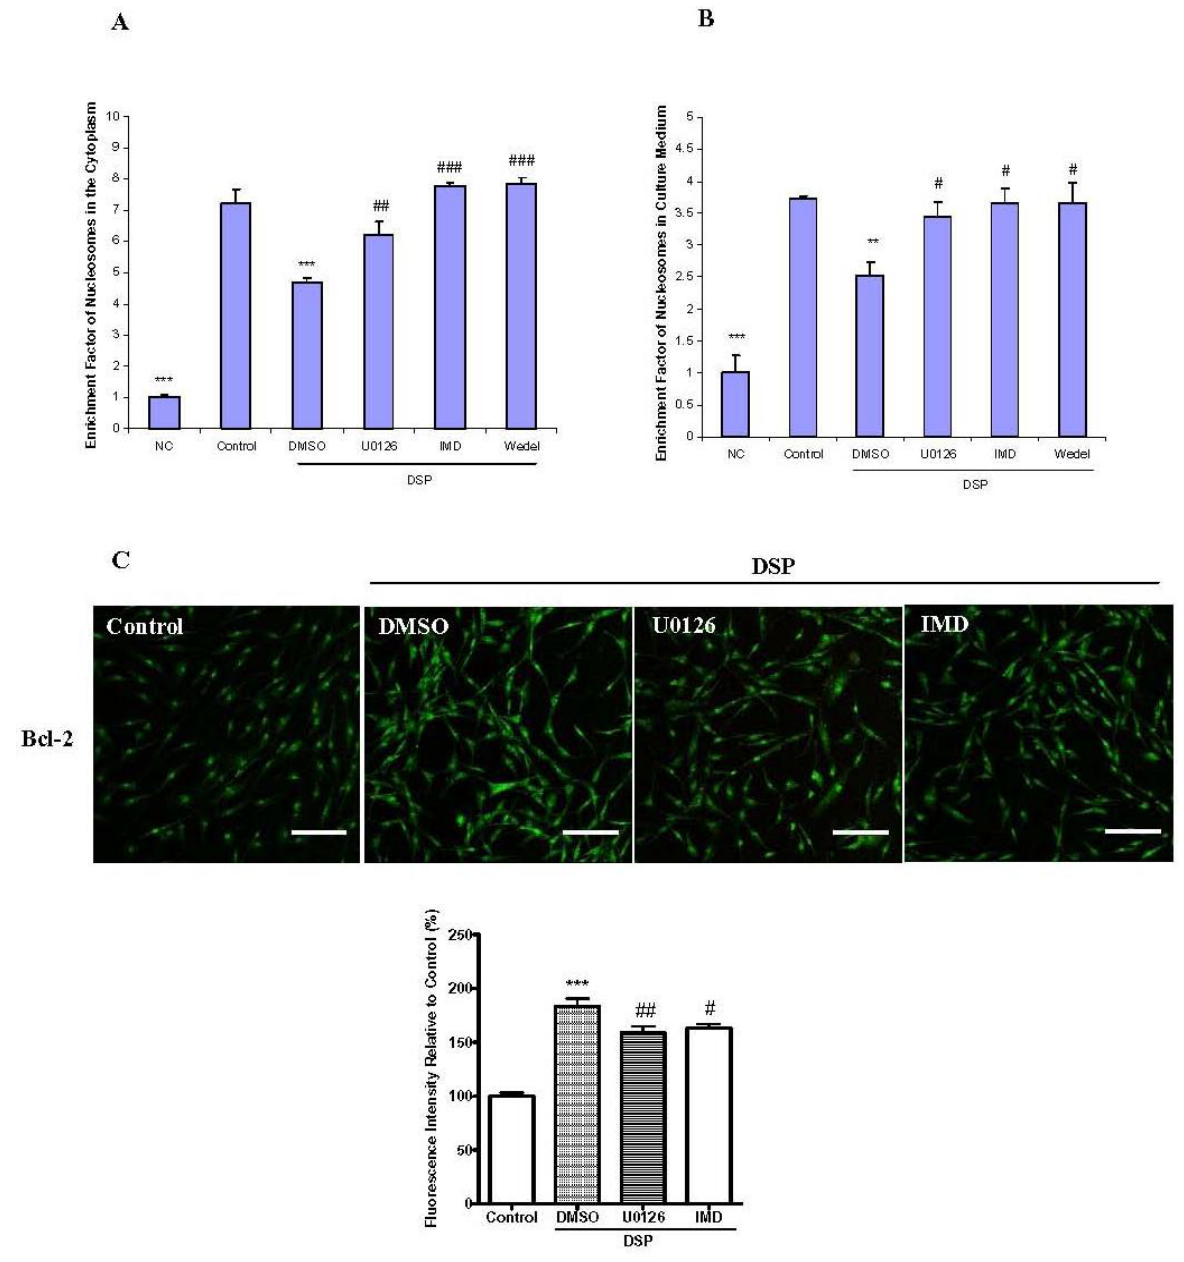
FIGURE 5. DSPs reduce serum starvation–induced apoptosis/necrosis and increase expression of Bcl-2 through activation of ERK and NF-κB in human VSMCs. Serum-starved cells were treated with 0.2 μl/ml of DSPs for 24 (C) or 48 h (A,B). The cells cultured in complete medium were regarded as negative control (NC). 10 μM of U0126, 5 μM of wedelolactone, or 30 nM of IMD-0354 were added to cells 30 min prior to treatment with DSPs. (A) DSP-induced anti–cell apoptosis is inhibited by MEK or NF-κB inhibitors. The rate of apoptosis is reflected by the enrichment factor of nucleosomes in the cytoplasm as determined by Cell Death Detection ELISA. (B) DSP-induced anti–cell necrosis is inhibited by MEK or NF-κB inhibitors. The rate of necrosis is reflected by the enrichment factor of nucleosomes in culture medium as determined by Cell Death Detection ELISA. (C) Bar graphs show the effects of MEK and NF-κB inhibitors on DSP-induced expression of Bcl- 2. The upper panels indicate representative images of immunofluorescence. The scale bar in each image represents 20 μm. Data represent mean ± S.E.M. ** p < 0.01, *** p < 0.001 vs. control; # p < 0.05, ## p < 0.01, ### p < 0.001 vs. DMSO; Wedel = wedelolactone; IMD =